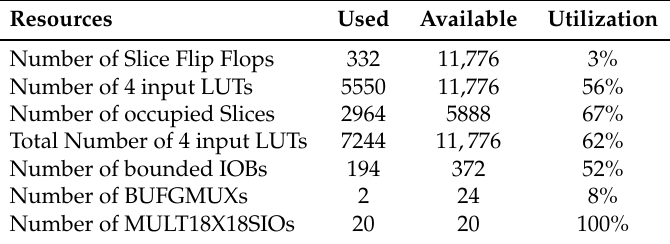
Table 3. FPGA utilization summary for the controlled Lorenz slave